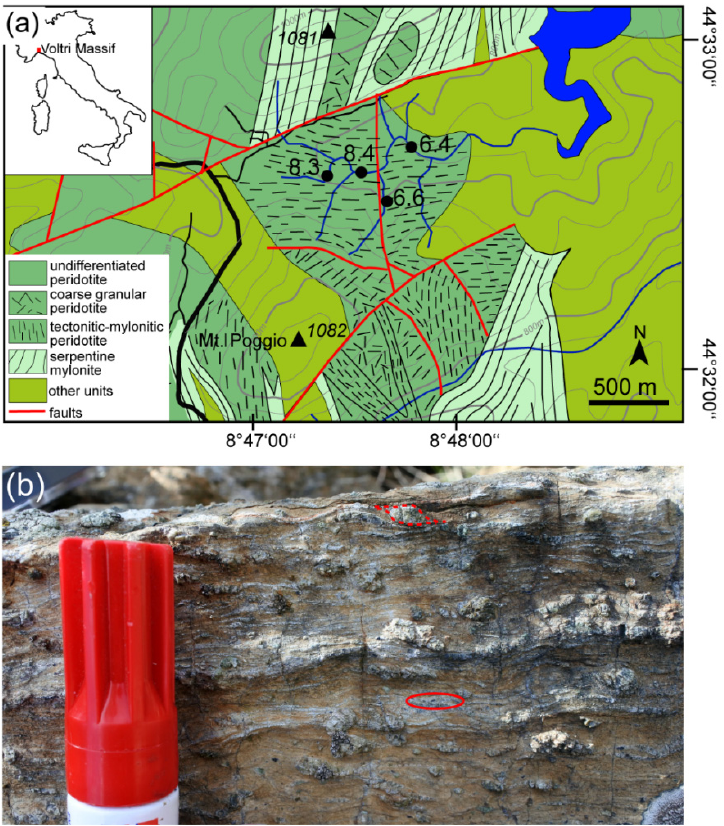
Figure 1. ( a ) Geological map of the field area with sample locations (black circles) modified after [41,61]. ( b ) Field photo of the spinel-bearing mylonites (location of Sample 6.4). In the red circle is a trail of elongated spinel. The dotted red line is a sigma opx porphyroclast indicating sinistral shear.